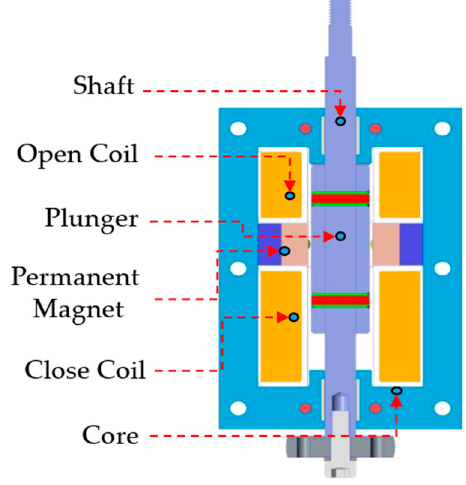
Figure 2. A traditional PMA type with plunger.